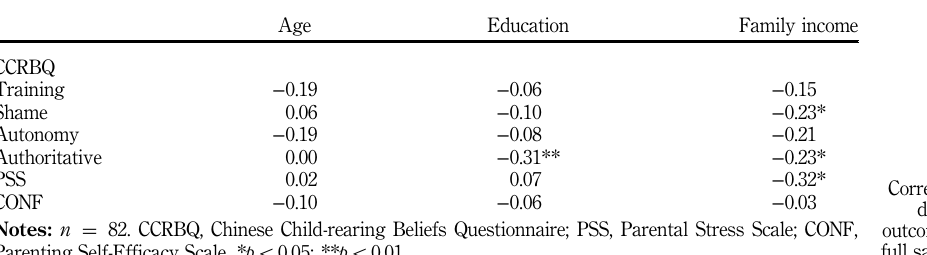
Table V. Correlations between demographic and outcome variables for full sample at